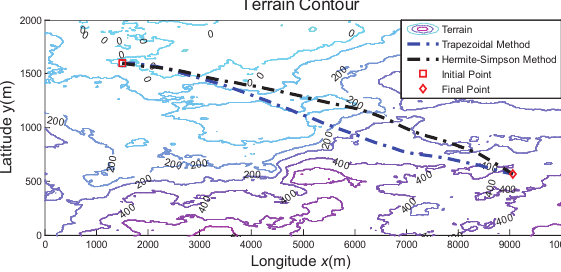
Figure 4. Optimal trajectory with the terrain contour